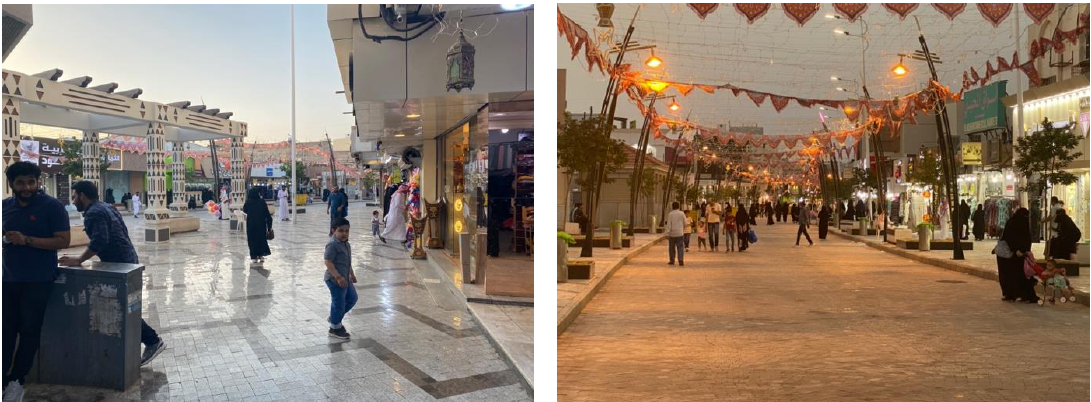
Figure 11. Social participation in Barzan main street. Source: Authors.